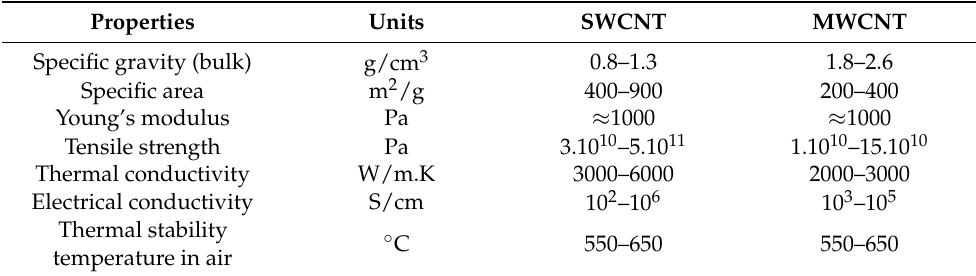
Table 2. Various properties of SWCNT and MWCNT